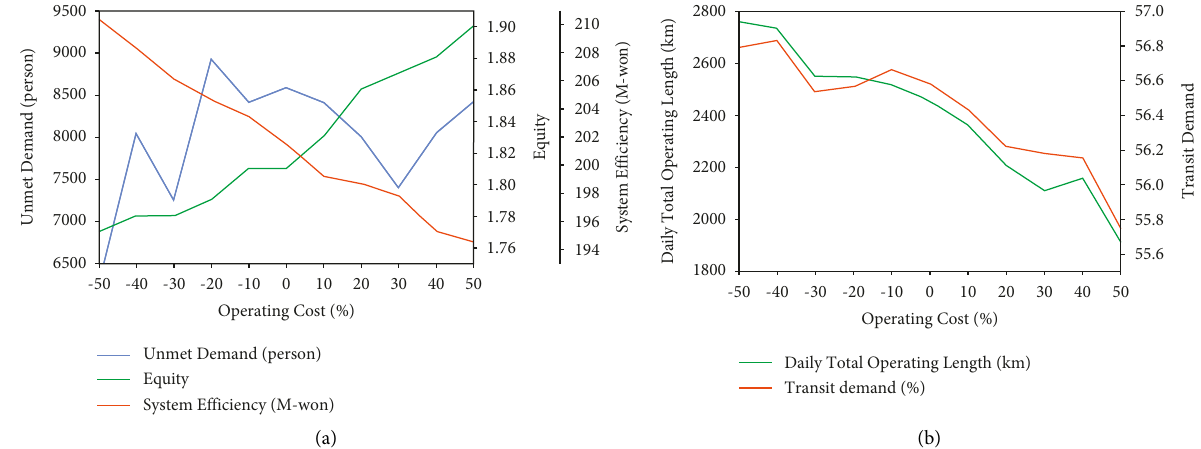
Figure 18: Sensitivity analysis for operating costs. (a) The three objective functions. (b) Daily total operating length and transit demand.